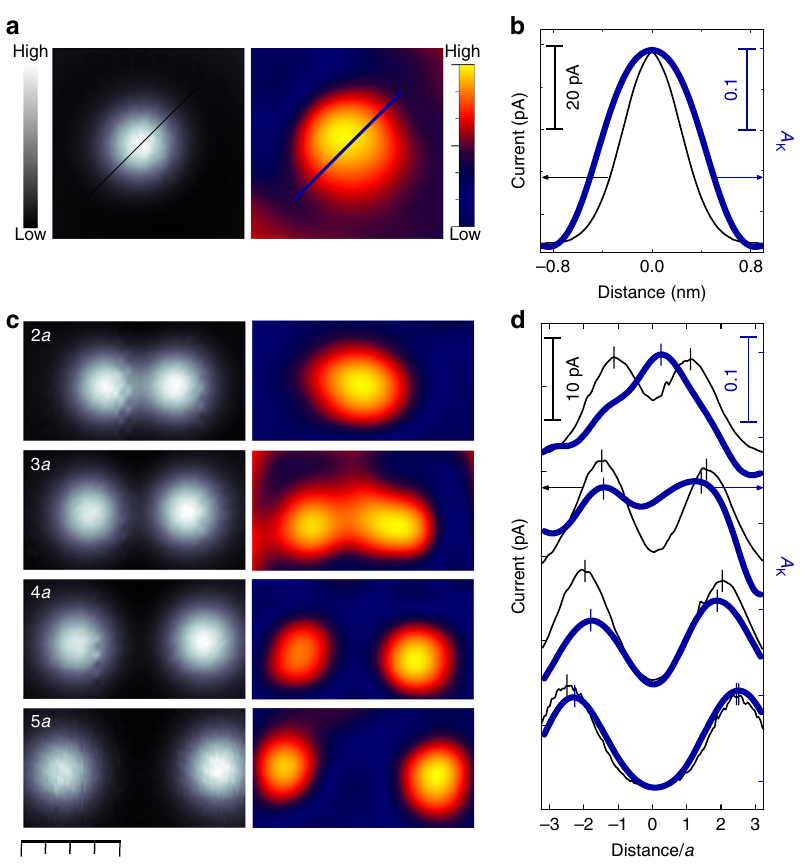
Fig. 3 Mapping of the experimental Kondo resonance amplitude in Co dimers. a Simultaneous constant height images of the tunnelling current (left) and Kondo amplitude, A K (right) of an individual Co atom. A K is the depth of the Kondo resonance, see Eq. (1) and Fig. 2a. b Line pro fi le across the atom (see lines in ( a )) of the current (thin black line) and A K (thick blue line). c The same as ( a ) for a Co dimer at d = 2 a , 3 a , 4 a , and 5 a modi fi ed by atomic manipulation ( a = 2.89 Å). d Horizontal pro fi les of the tunnelling current (black thin lines), and A K (blue thick line) from ( c ). Data were vertically offset for clarity. All tunnelling current images (greyscale) were acquired at V ref = 17 mV sample bias. Bottom scale bar corresponds to 1